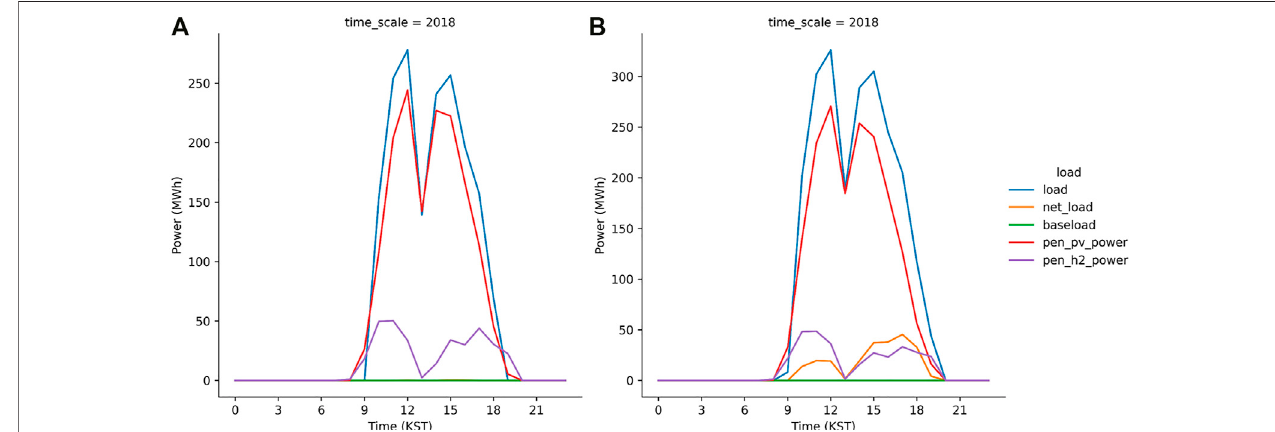
FIGURE 11 | Same as Figure 8 but from S2 run (A) and S3 run (B) .